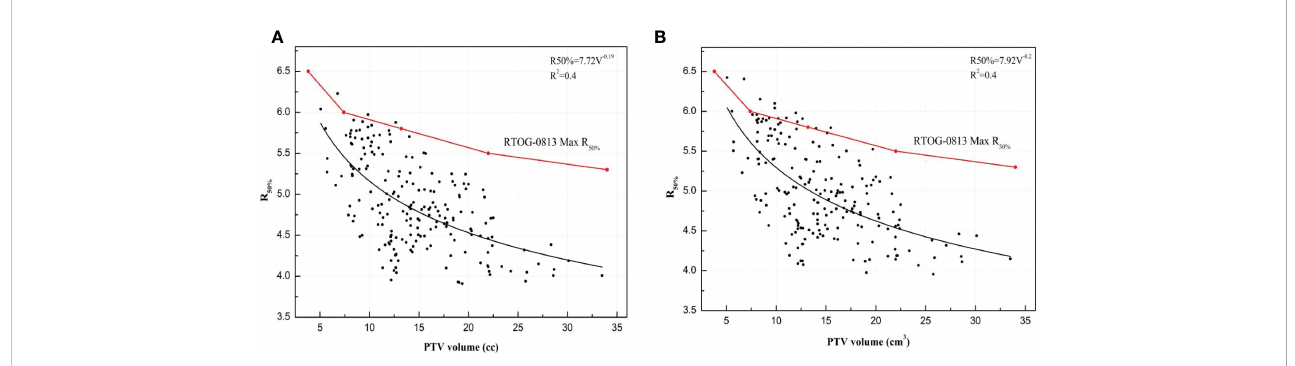
FIGURE 6 The R 50% for VMAT FFF and VMAT FF plans plotted with PTV volume and was presented by a power functional form: (A) R 50% of VMAT FFF plan. (B) R 50% of VMAT FF